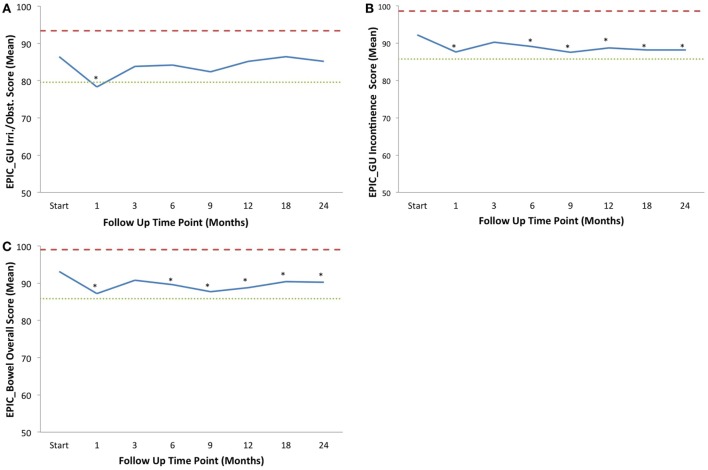
Average EPIC domain scores at baseline and following IMRT plus SBRT boost for prostate cancer. Shown are plots for: (A) EPIC urinary irritation/obstruction domain, (B) EPIC urinary incontinence domain, and (C) EPIC bowel domain. The thresholds for clinically significant changes in scores (½ SD above and below the baseline) are marked with dashed lines. IPSS scores range from 0 to 35 with higher values representing worsening urinary symptoms. EPIC scores range from 0 to 100 with higher values representing a more favorable health-related QOL. Thresholds for clinically significant changes in scores (½ SD above and below the baseline) are marked with dashed lines. EPIC scores range from 0 to 100 with higher values representing a more favorable health-related QOL.